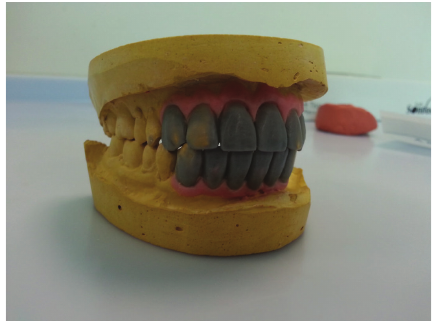
Figure 2: Diagnostic wax up of the diagnostic cast.